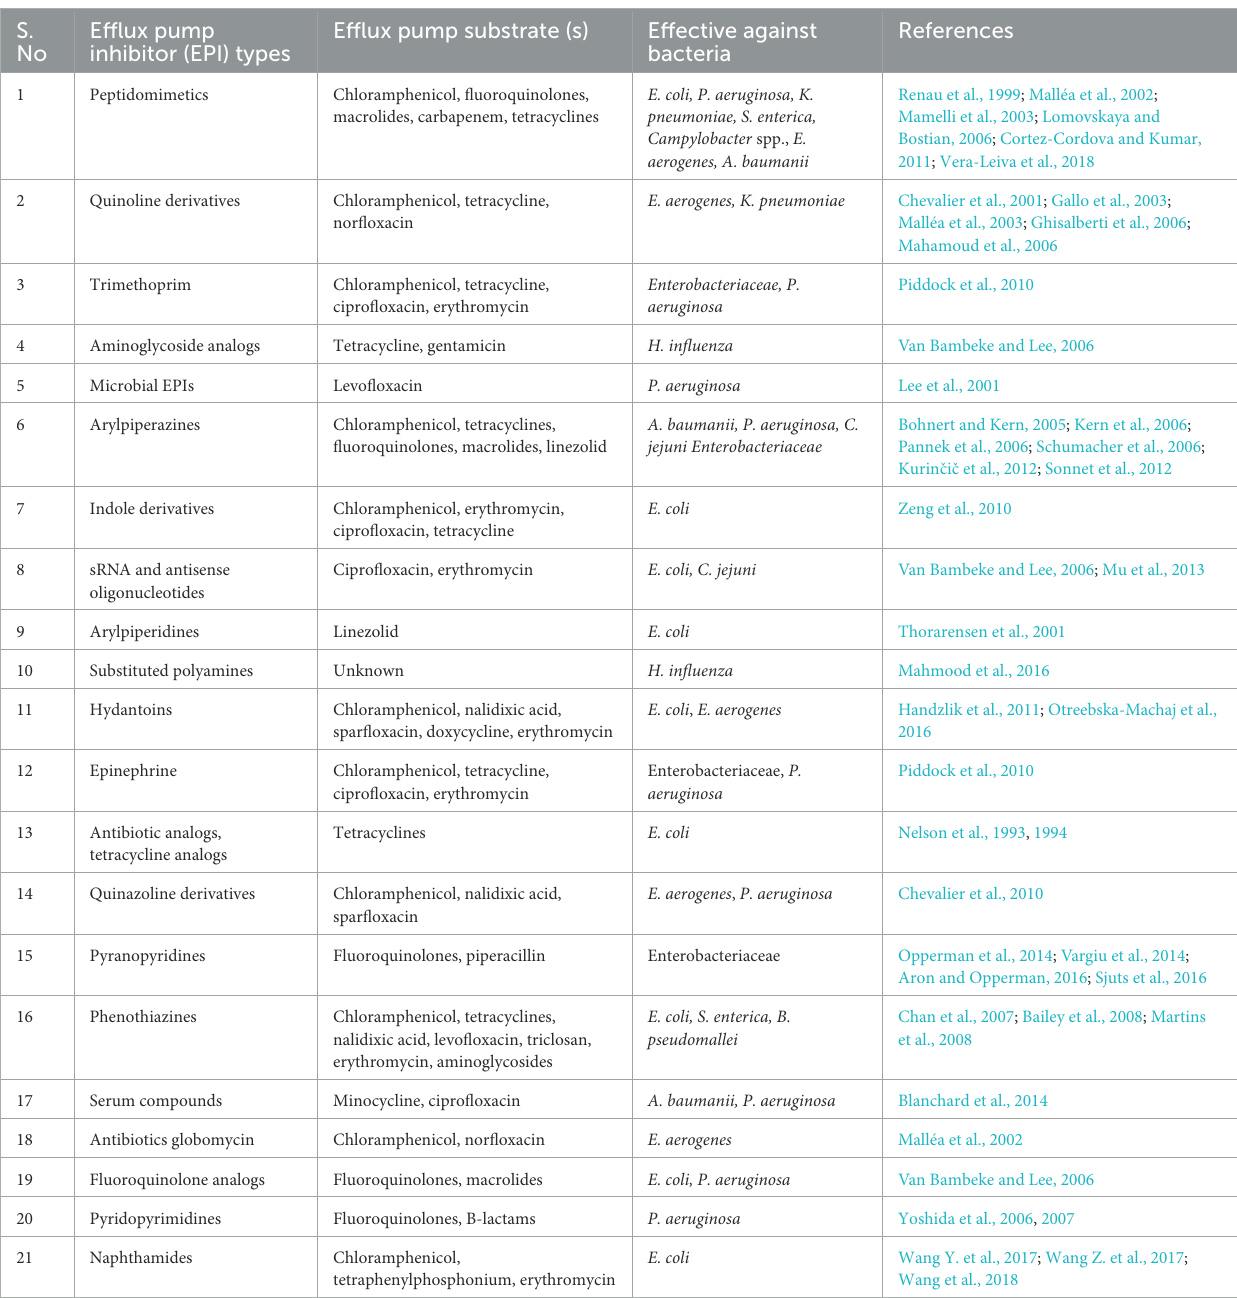
TABLE 1 Examples of synthetic efflux pump inhibitors (EPIs) having inhibitory action against Gram-negative bacteria. S.